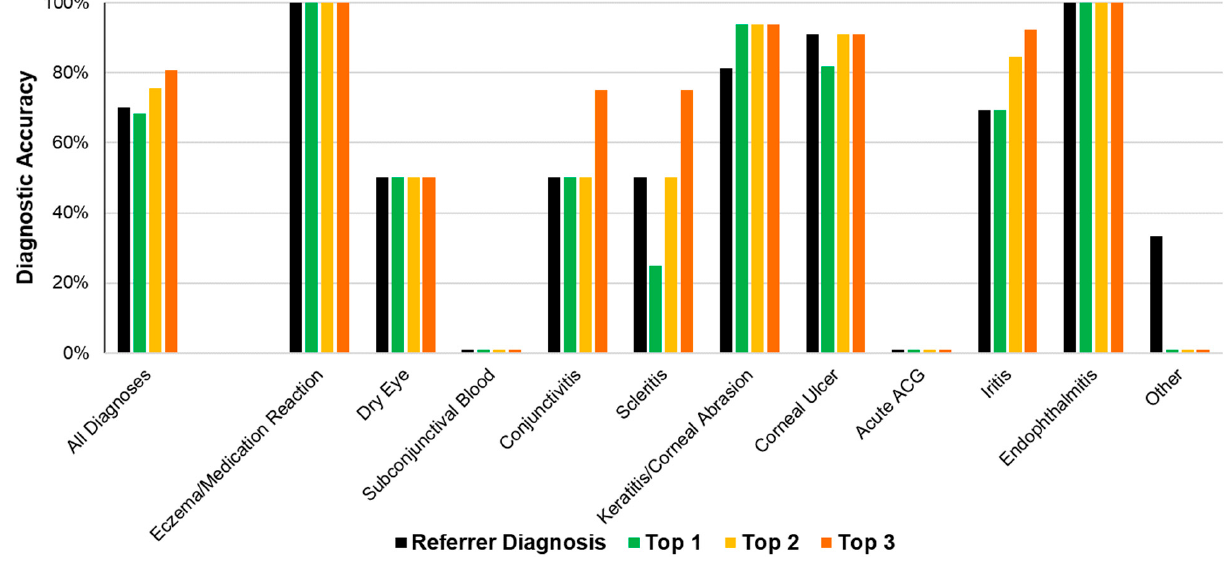
Figure 3. Referrer and algorithm diagnostic accuracies. Table 2. Referrer and algorithm diagnostic accuracies.